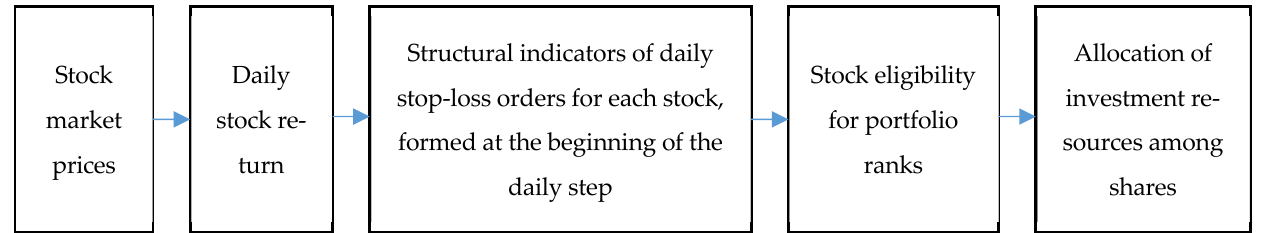
Figure 1. Decision-making scheme (source: compiled by the authors).